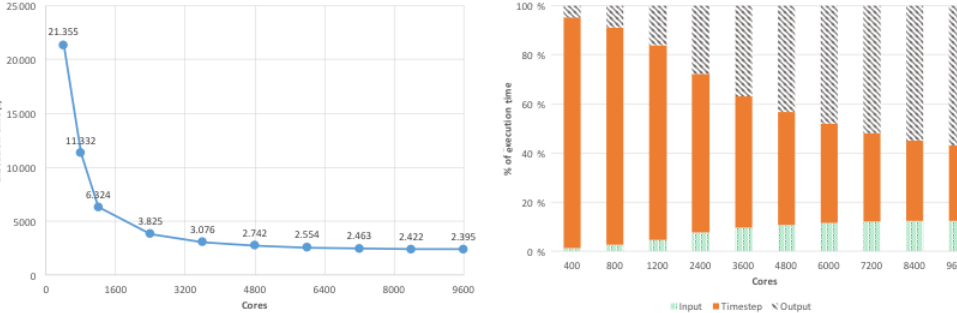
Figure 21. Execution time at TUPA of the 5km grid and processes responsibility.